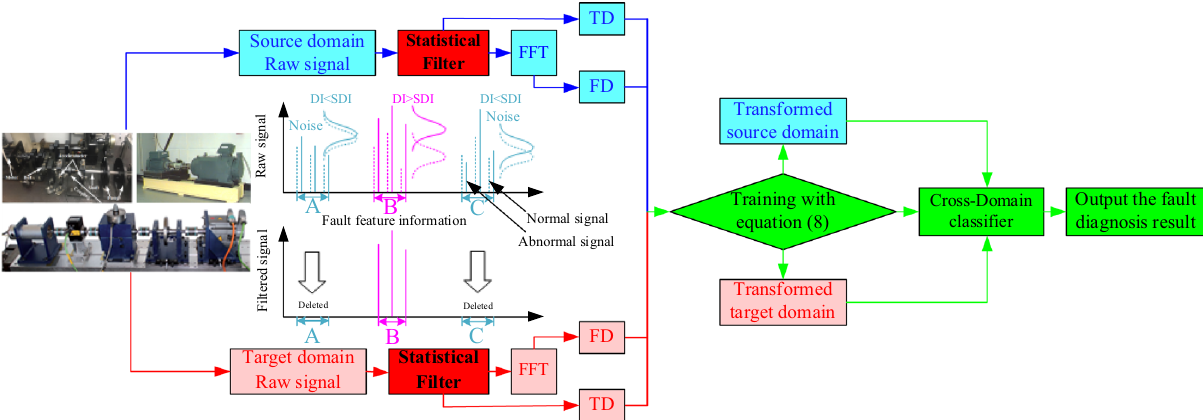
Figure 1. Flowchart of the proposed method